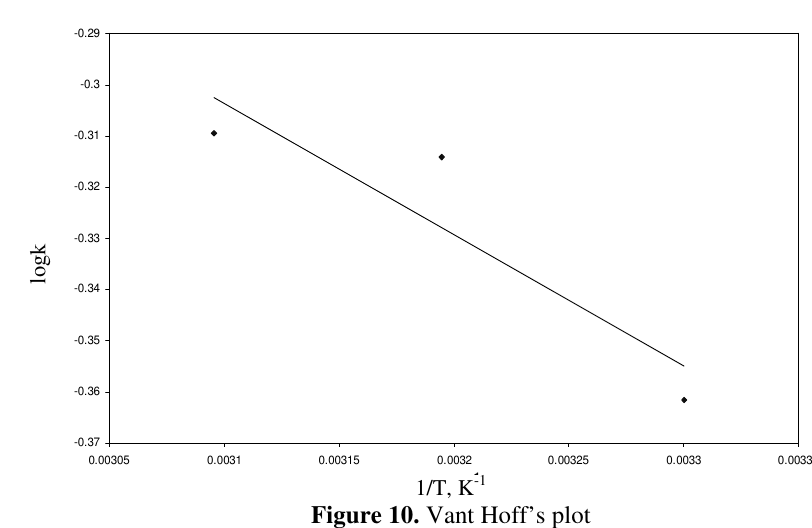
Figure 10. Vant Hoff’s